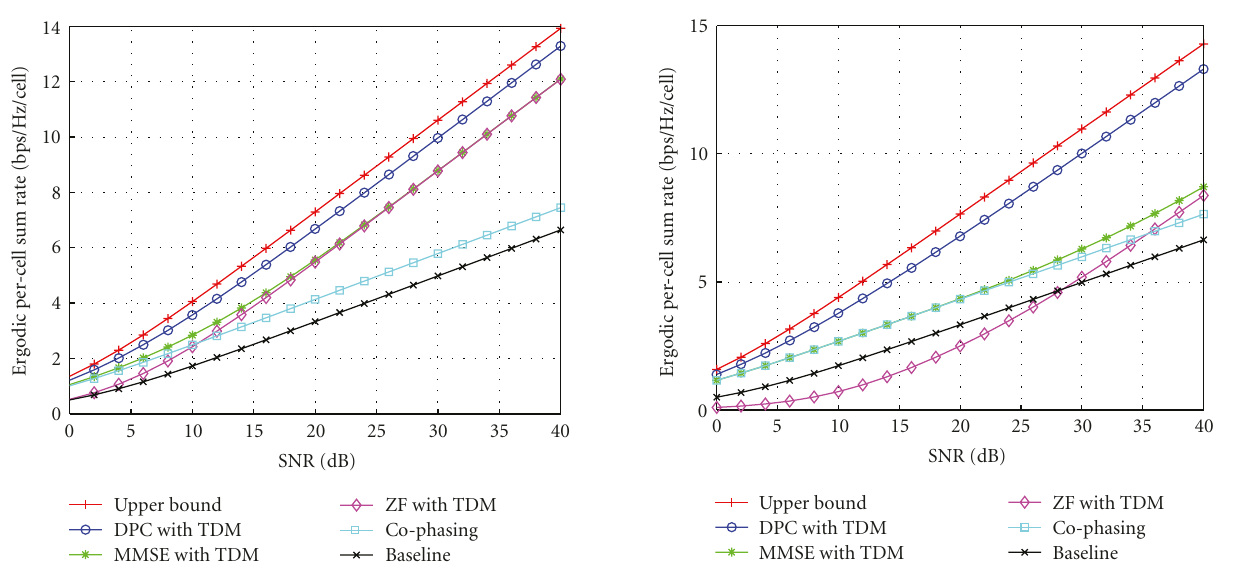
Figure 5: (32,5) single-class network, α = 0 . 75 . Figure 6: (32,5) single-class network, α = 1